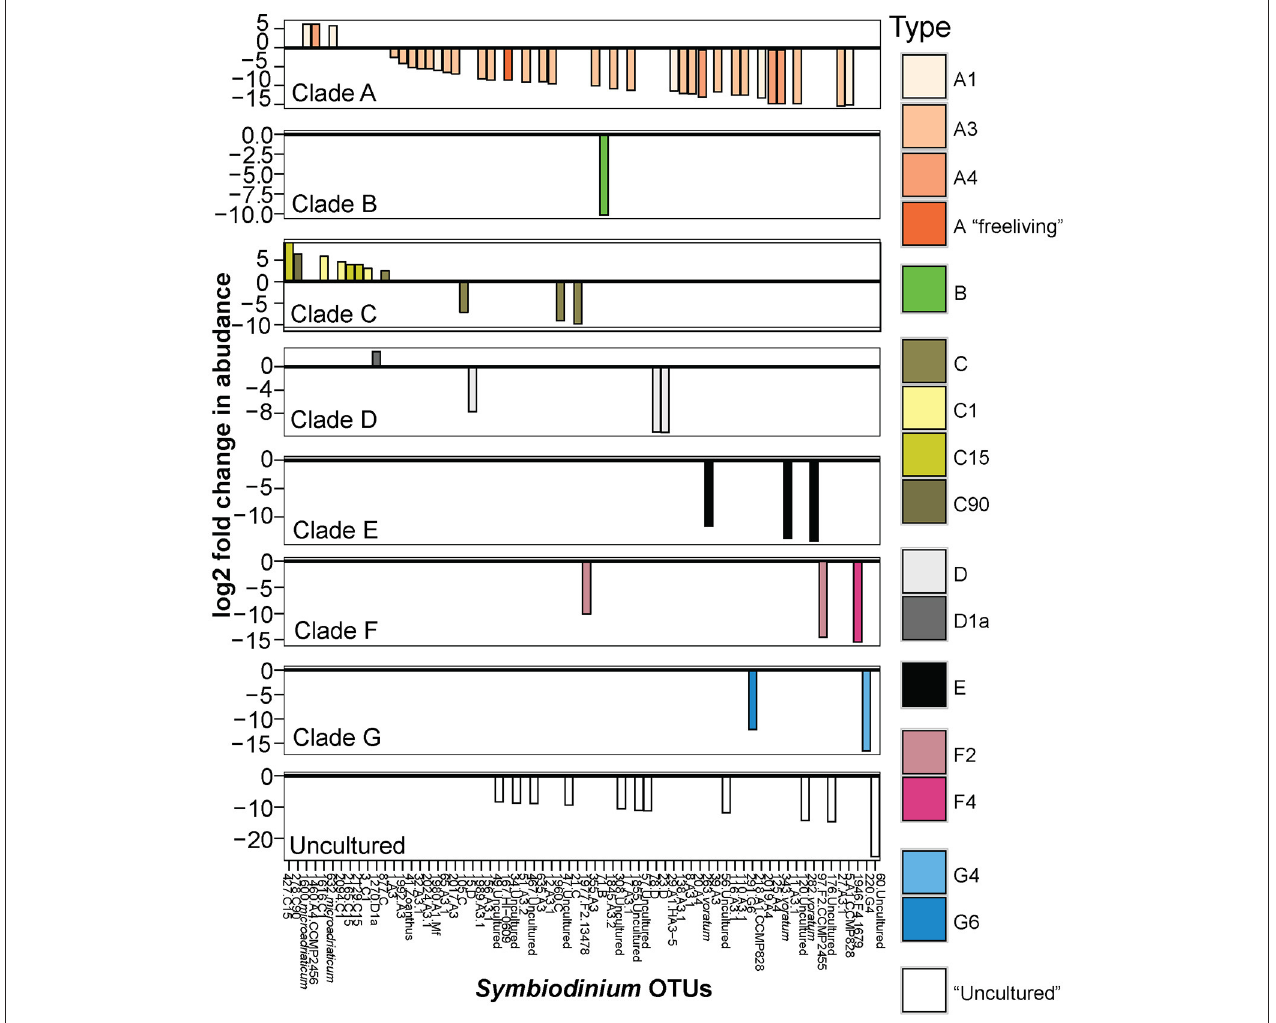
FIGURE 2 | Significant log2 fold changes in normalized abundances of Symbiodinium OTUs in sediment-exposed juveniles compared to sediment samples. Colors represent the classification of different Symbiodinium types. Positive values above the y = 0 line (in bold and black) denote Symbiodinium OTUs found in significantly greater abundances in juveniles compared to sediments. Note the different scales on the